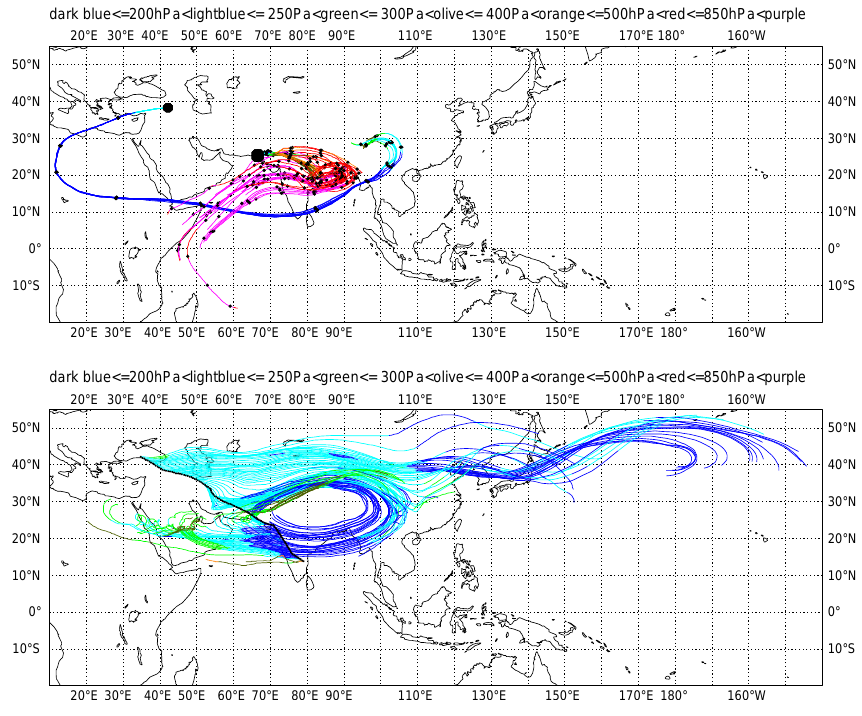
Figure 9: Top: Ten day backward trajectories for two samples collected at 216 hPa and at 196 hPa on August 13th 2008 during a flight from Frankfurt to Chennai. Along the Fig. 9. Top: Ten day backward trajectories for two samples collected at 216hPa and at 196hPa on 13 August 2008 during a flight from Frankfurt to Chennai. Along the trajectories, small markers indicate time steps of 24h, the large symbols denote the sampling positions. trajectories, small markers indicate time steps of 24 hours, the large symbols denote the Bottom: Five day forward trajectories calculated every 3min along the flight track on August 13th sampling positions. Bottom: Five day forward trajectories calculated every 3 min along the flight track on August 13th 2008.